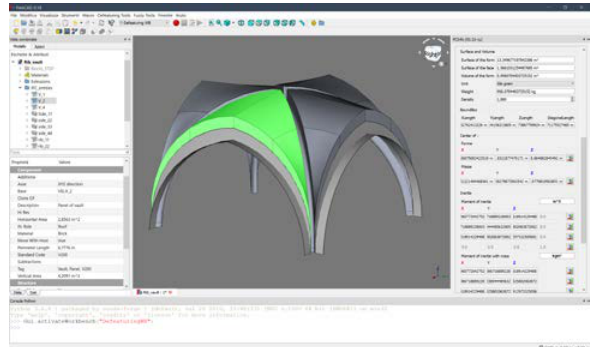
Figure 12. FreeCAD platform and creation of parametric object